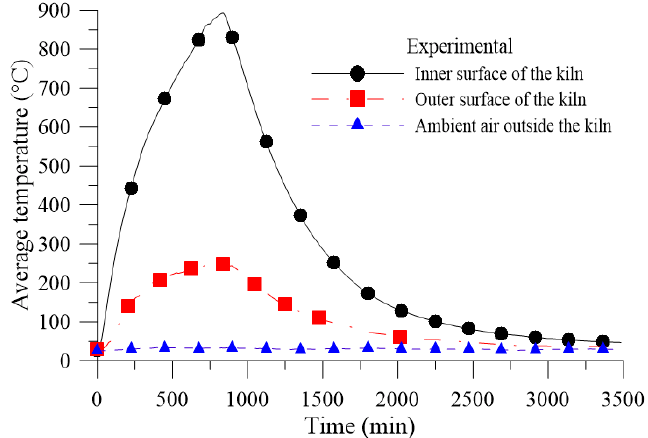
Figure 8. Temperatures of the kiln's internal and external surfaces, and ambient surroundings of the kiln as a function of time.